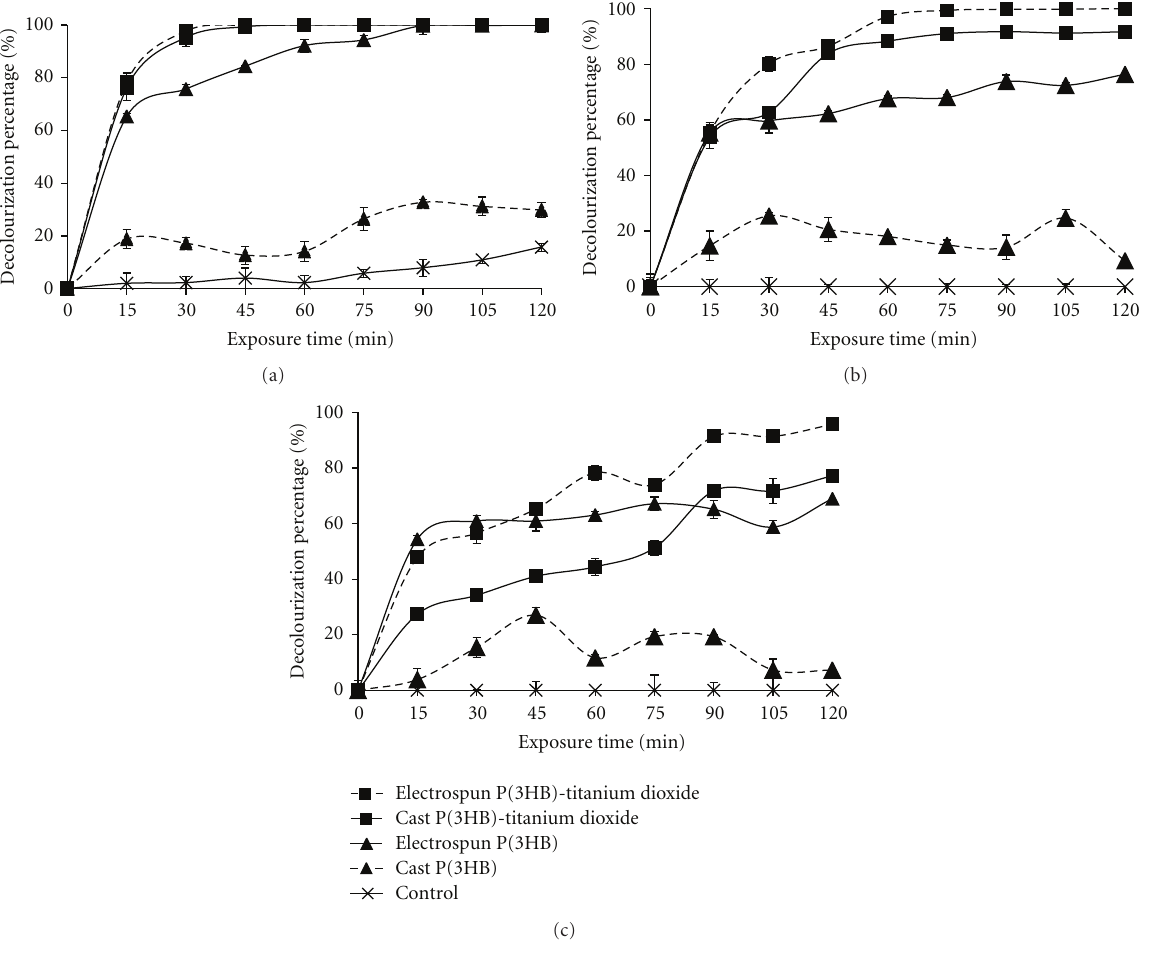
Figure 4: The decolorization percentage of MG over time using cast and electrospun P(3HB) and P(3HB)-50 wt% TiO 2 film under (a) sunlight, (b) UV light, and (c) fluorescent